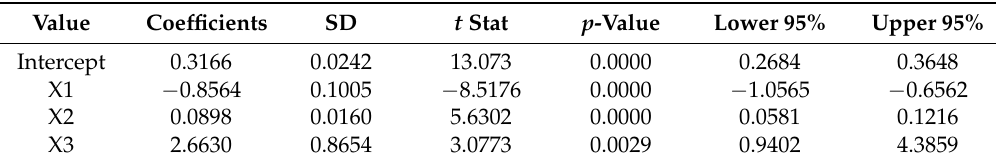
Table 3. Parameter table of multiple liner regression